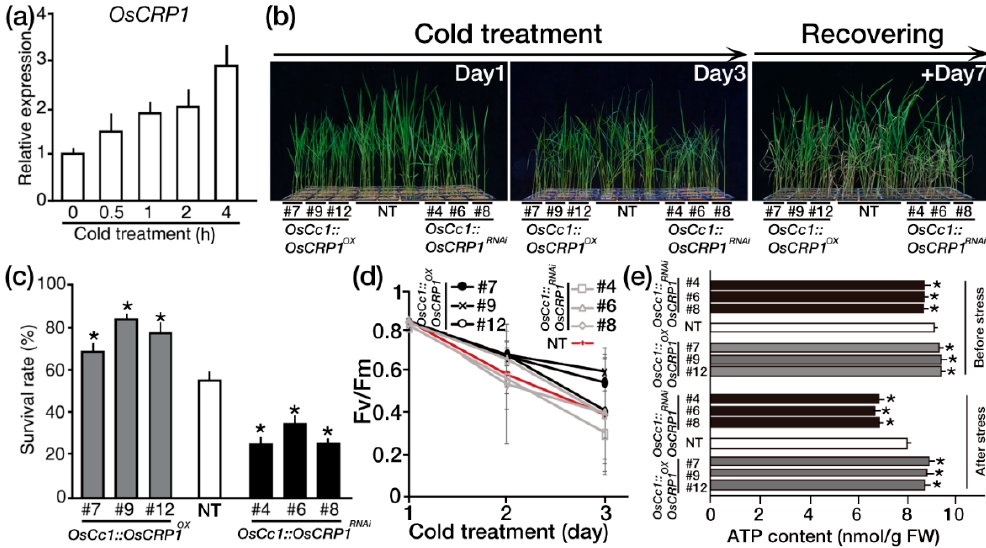
Figure 4. OsCRP1 overexpression in rice confers cold tolerance. ( a ) Relative expression of OsCRP1 in response to cold stress. Two-week-old seedlings were exposed to at 4 °C (low temperature) for the indicated times. OsUbi1 expression was used as an internal control. Values are the means ± SD of three independent experiments. ( b ) Phenotypes of OsCc1::OsCRP1 OX and OsCc1::OsCRP1 RNAi transgenic rice plants under cold stress at the vegetative stage. Three independent homozygous OsCc1::OsCRP1 OX and OsCc1::OsCRP1 RNAi lines and NT control plants were grown in soil for 2 weeks and exposed to cold stress for 3 days, followed by recovery. ( c ) Survival rate scored 7 days after recovery. Values represent means ± SD of three repeated tests. Asterisks indicate significant differences compared with NT (* p < 0.05, One-way ANOVA). ( d ) Chlorophyll fluorescence (Fv/Fm) of OsCc1::OsCRP1 OX , NT and OsCc1::OsCRP1 RNAi plants during a 3-day cold treatment. Fv/Fm values were measured in the dark to ensure sufficient dark adaptation. Data are shown as the mean ± SD ( n = 30). ( e ) ATP contents in leaves of the OsCc1::OsCRP1 OX , NT and OsCc1::OsCRP1 RNAi plants under before and after cold stress conditions. Ten two-week-old plants were used for each line, and the middle portion of the second leaf from the top was taken for analysis. Data bars represent the mean ± SD of three biological replicates, each of which had two technical replicates. Asterisks indicate significant differences compared with NT (* p < 0.05, One-way ANOVA).